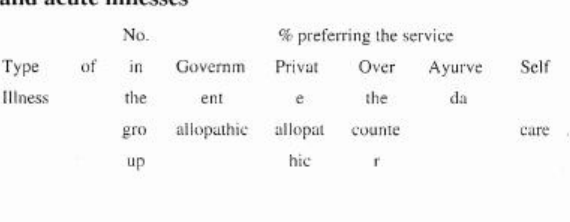
Table6 - Preferencefor treatmentofchronic